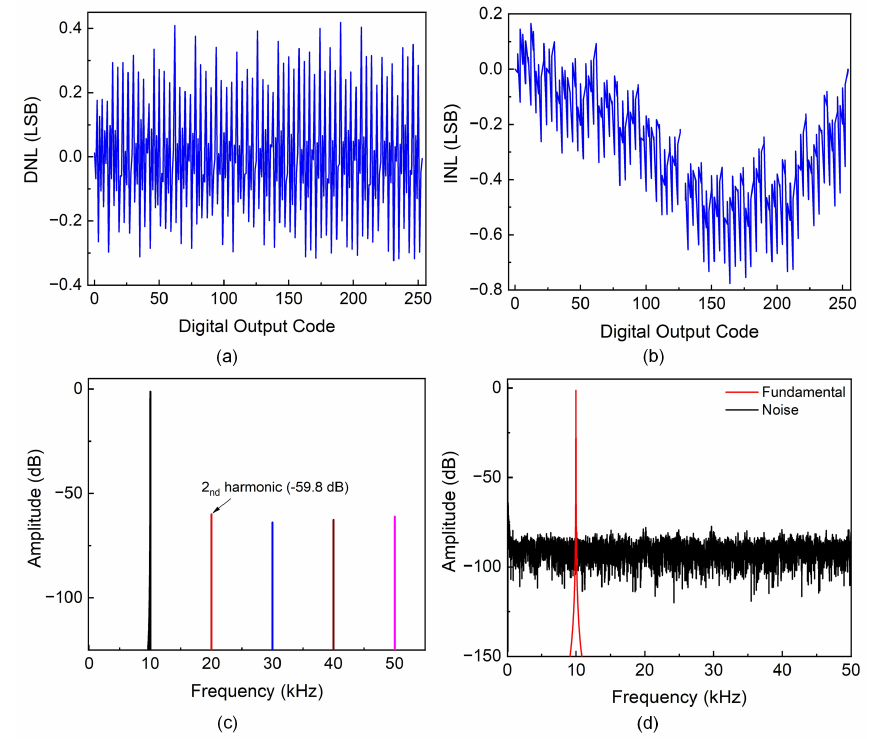
Figure 5. ( a ) ADC differential nonlinearity (DNL), ( b ) ADC integral nonlinearity (INL), ( c ) ADC total harmonic distortion power spectrum (fundamental vs. harmonics), and ( d ) signal-to-noise ratio power spectrum (fundamental vs.